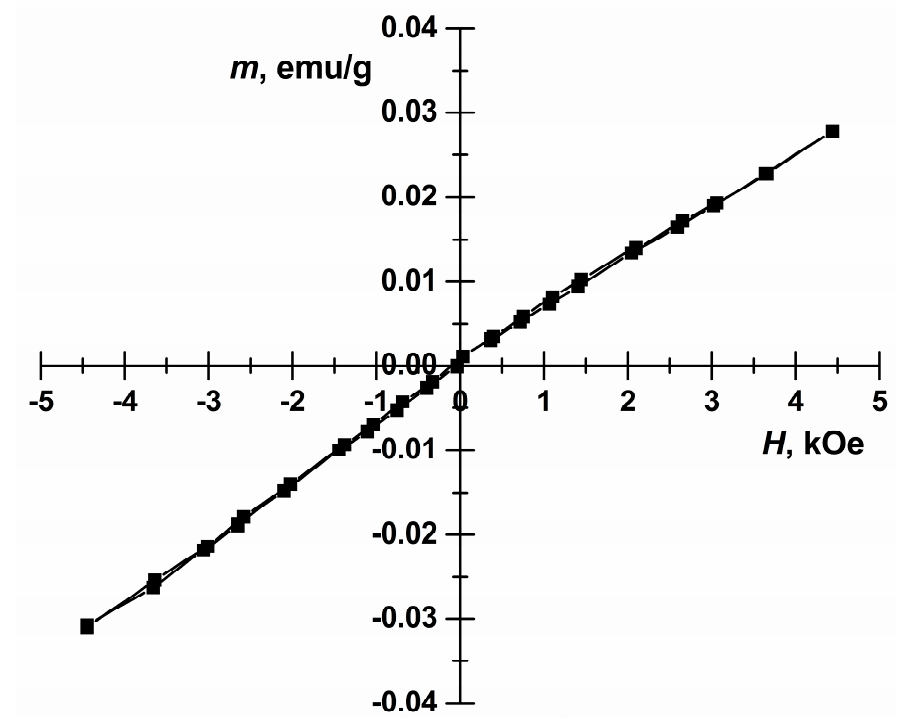
Figure 4. Magnetic hysteresis of BFO powders annealed at 650 ◦